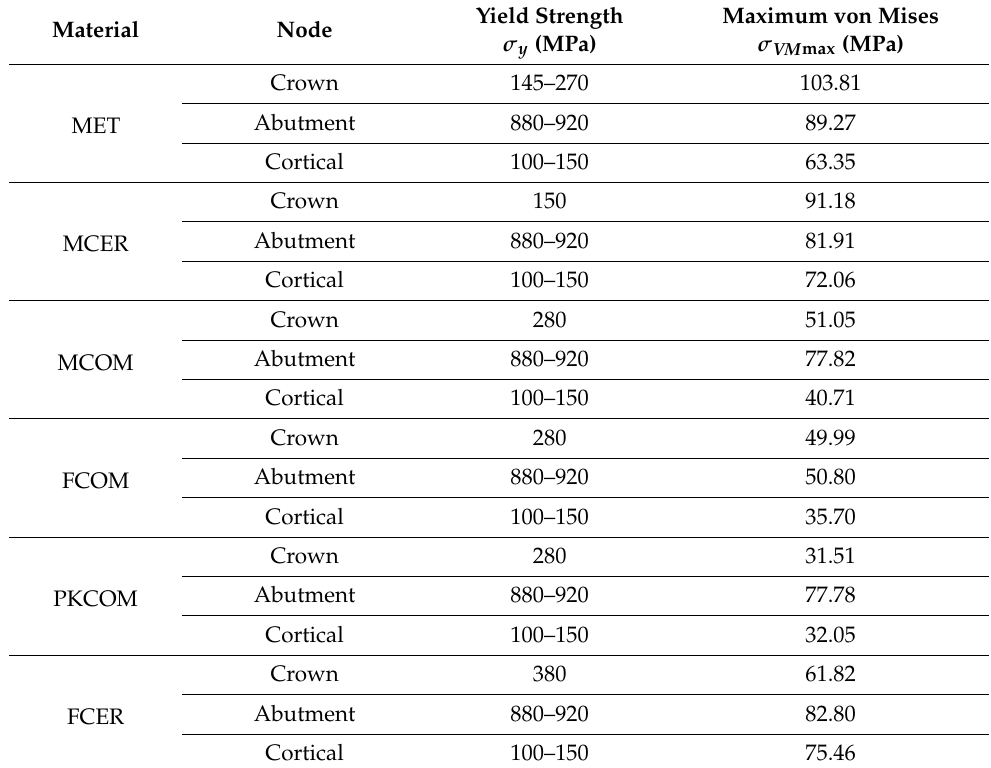
Table 3. Comparison of the yield stress, σ y , and the maximum value of stress, σ VM max , for each material and